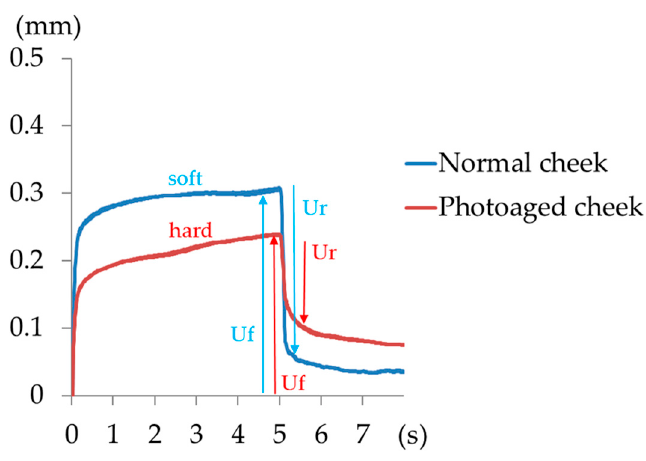
Figure 1. The typical curves of normal skin and photoaging skin measured by the Cutometer MPA580.